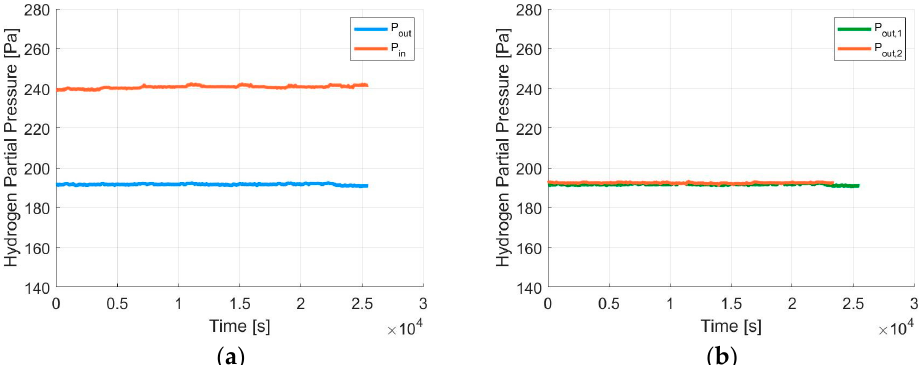
Figure 5. Examples of partial pressure measured by the HPSs at the inlet and at the outlet of the PAV mock-up ( a ) and of partial pressure measured by the HPSs installed at the outlet of the PAV mock-up by HLM733 (orange line) and HLM735 (green line) ( b ).